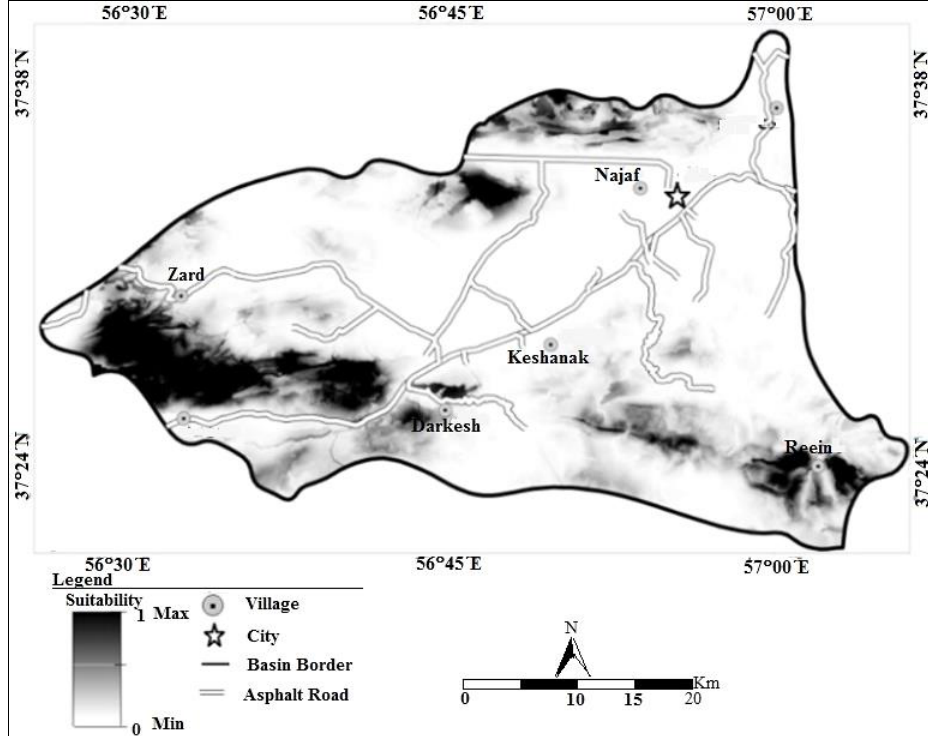
Figure 2. The Habitat continuous map